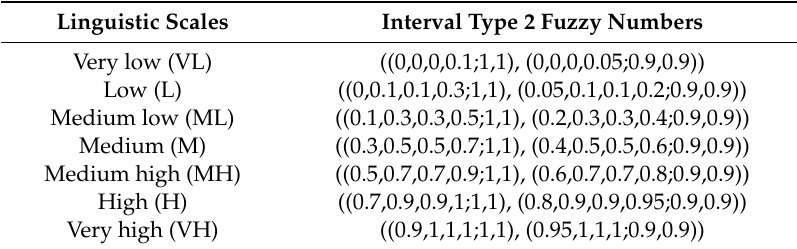
Table 1. Linguistic evaluations and fuzzy numbers for the